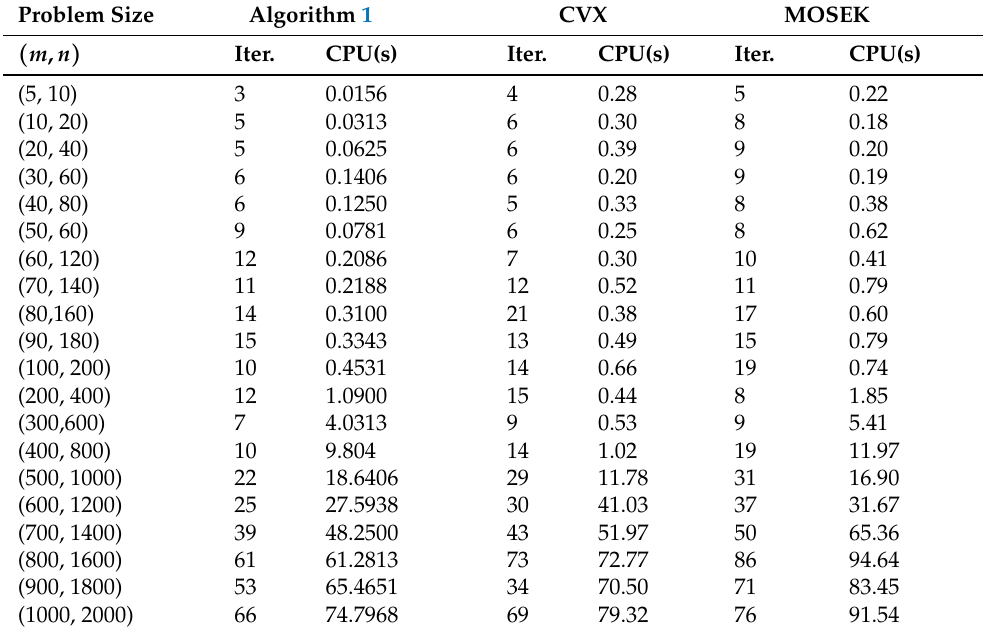
Table 4. The numerical results obtained for the randomly generated problems in Example